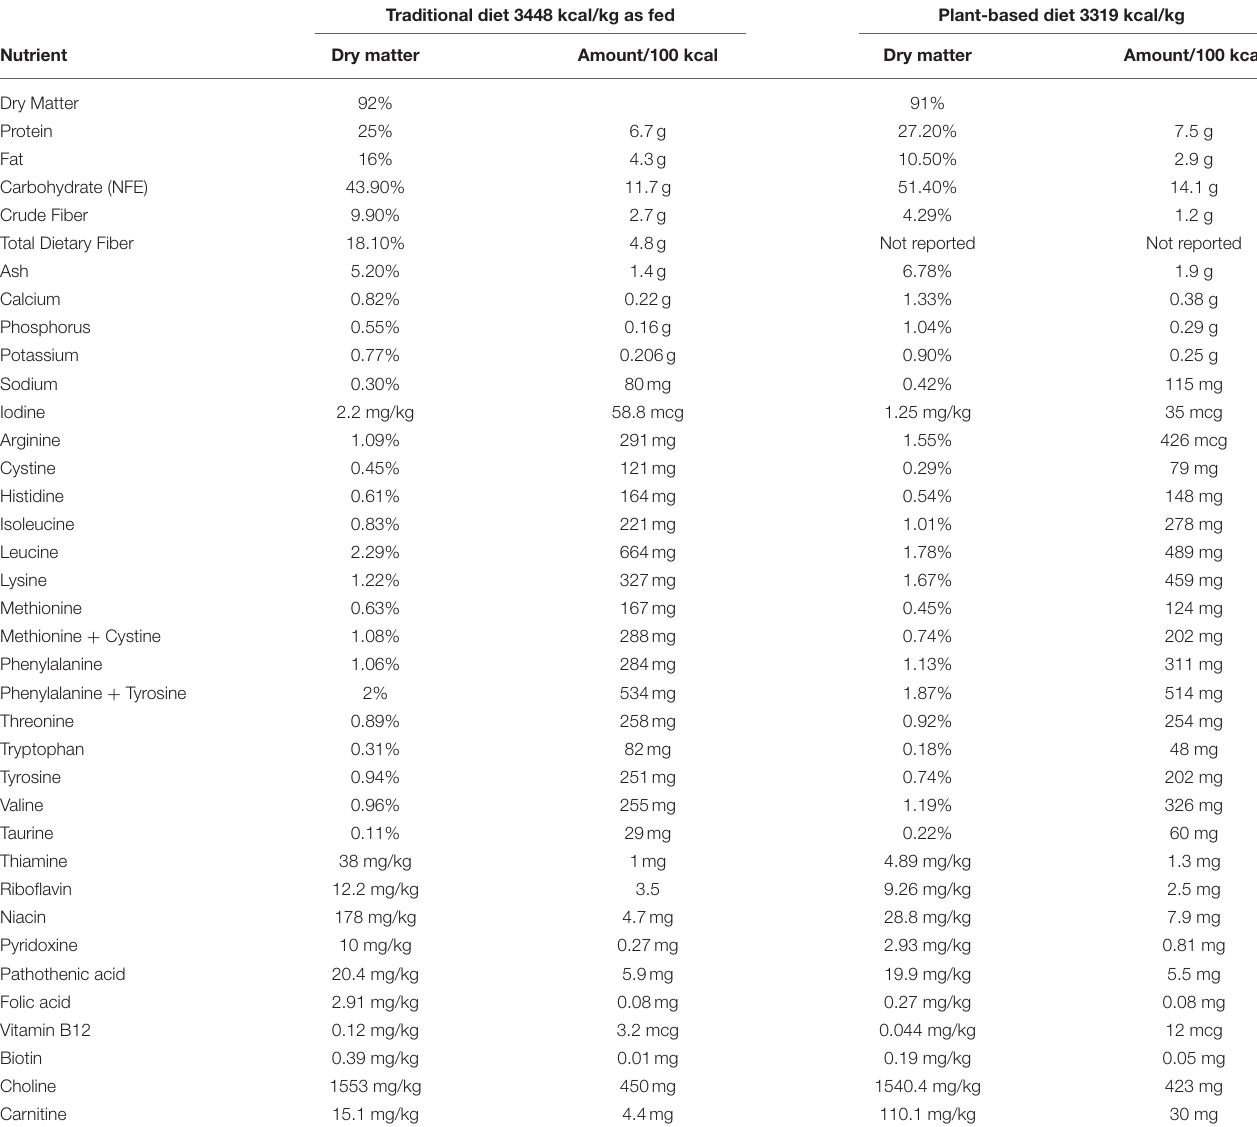
TABLE 1 | Calculated macro- and micronutrient content from the typical nutritional analysis * of the traditional diet and the plant-based diet. Traditional diet 3448 kcal/kg as fed Plant-based diet 3319